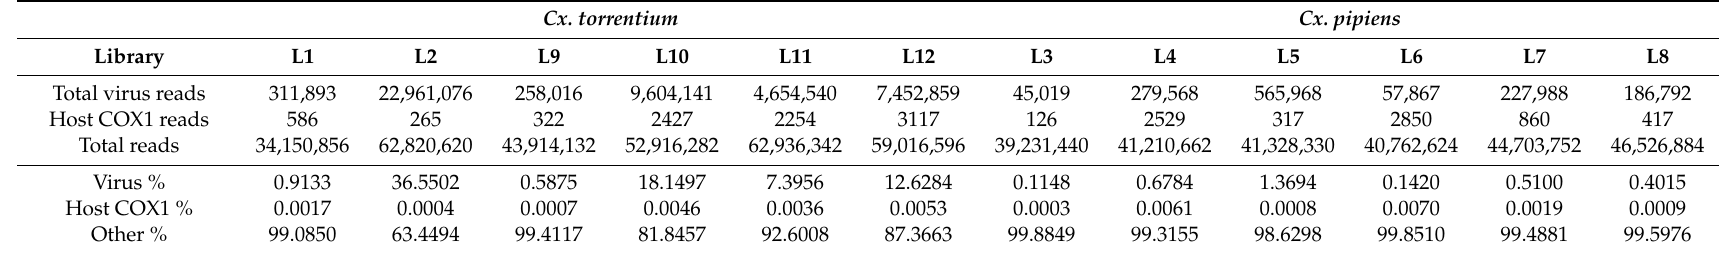
Table 1. Overview of viral RdRp-motif library content compared to the total number of non-viral RNA reads per library. Cx. torrentium Cx.